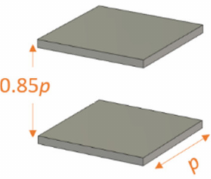
Figure 10. Two empty parallel plates unit cell ( E